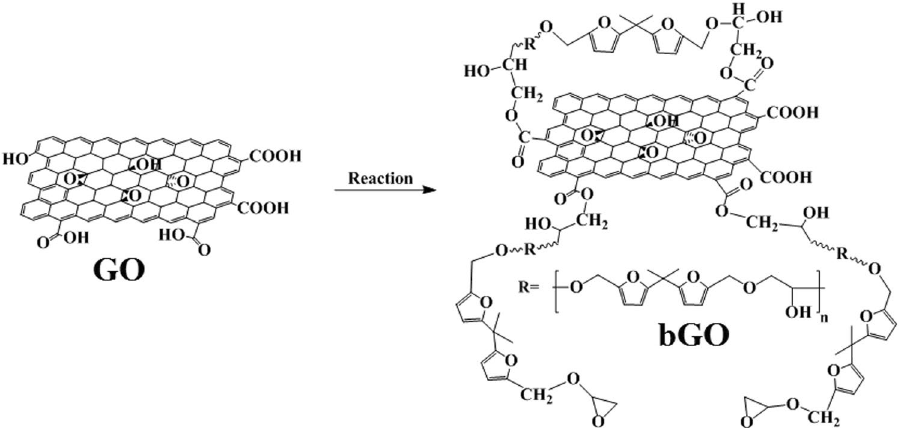
Figure 1. Synthesis of functionalised GO via covalent reaction between BFDE and